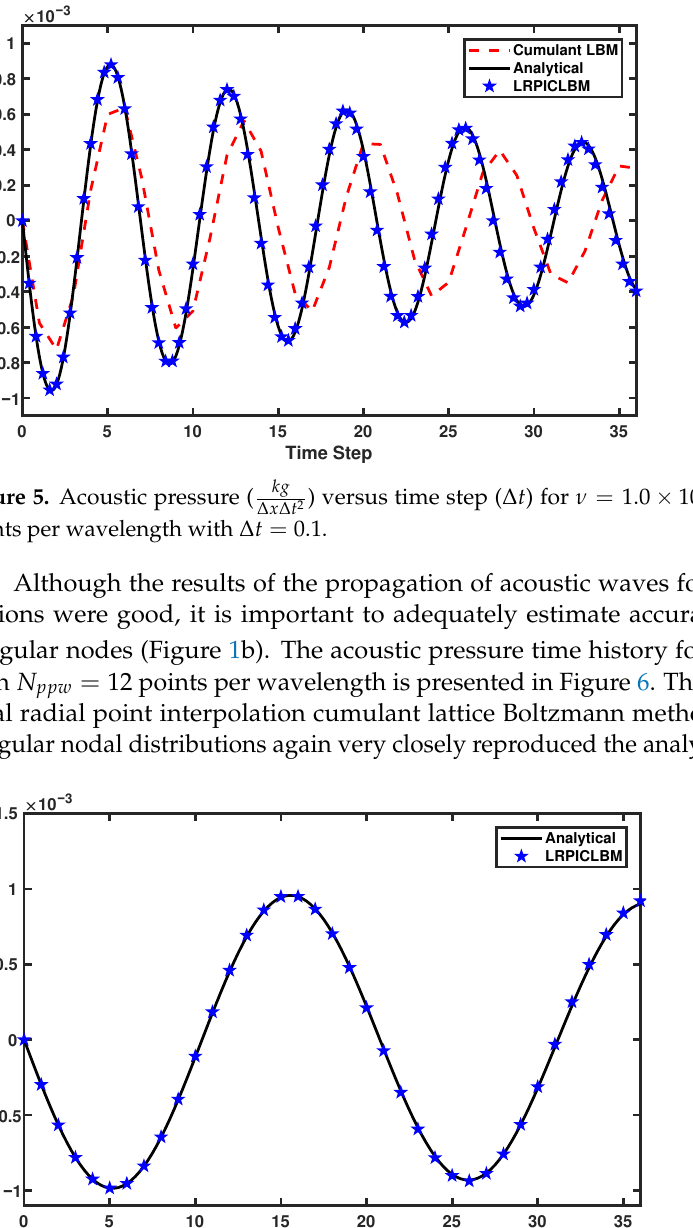
) versus time step ( ∆ t ) for ν = 1.0 × 10 − 2 ( x ∆ t 2